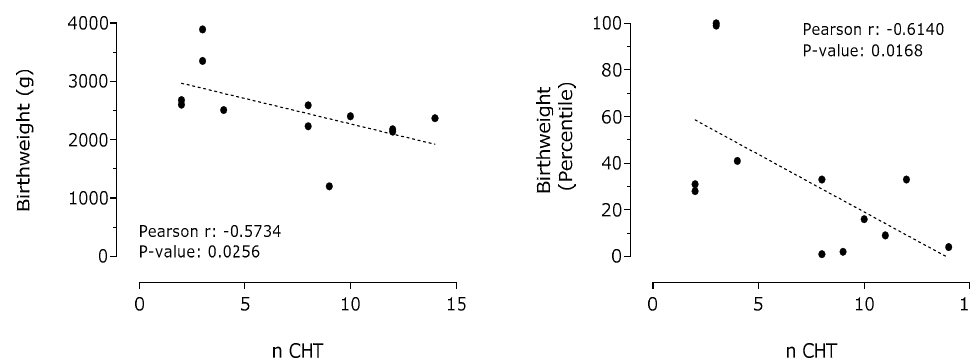
Figure 5. Correlation between cycles of chemotherapy administered (n CHT) and birth weight or percentile in pregnant women affected by breast cancer ( n = 12).